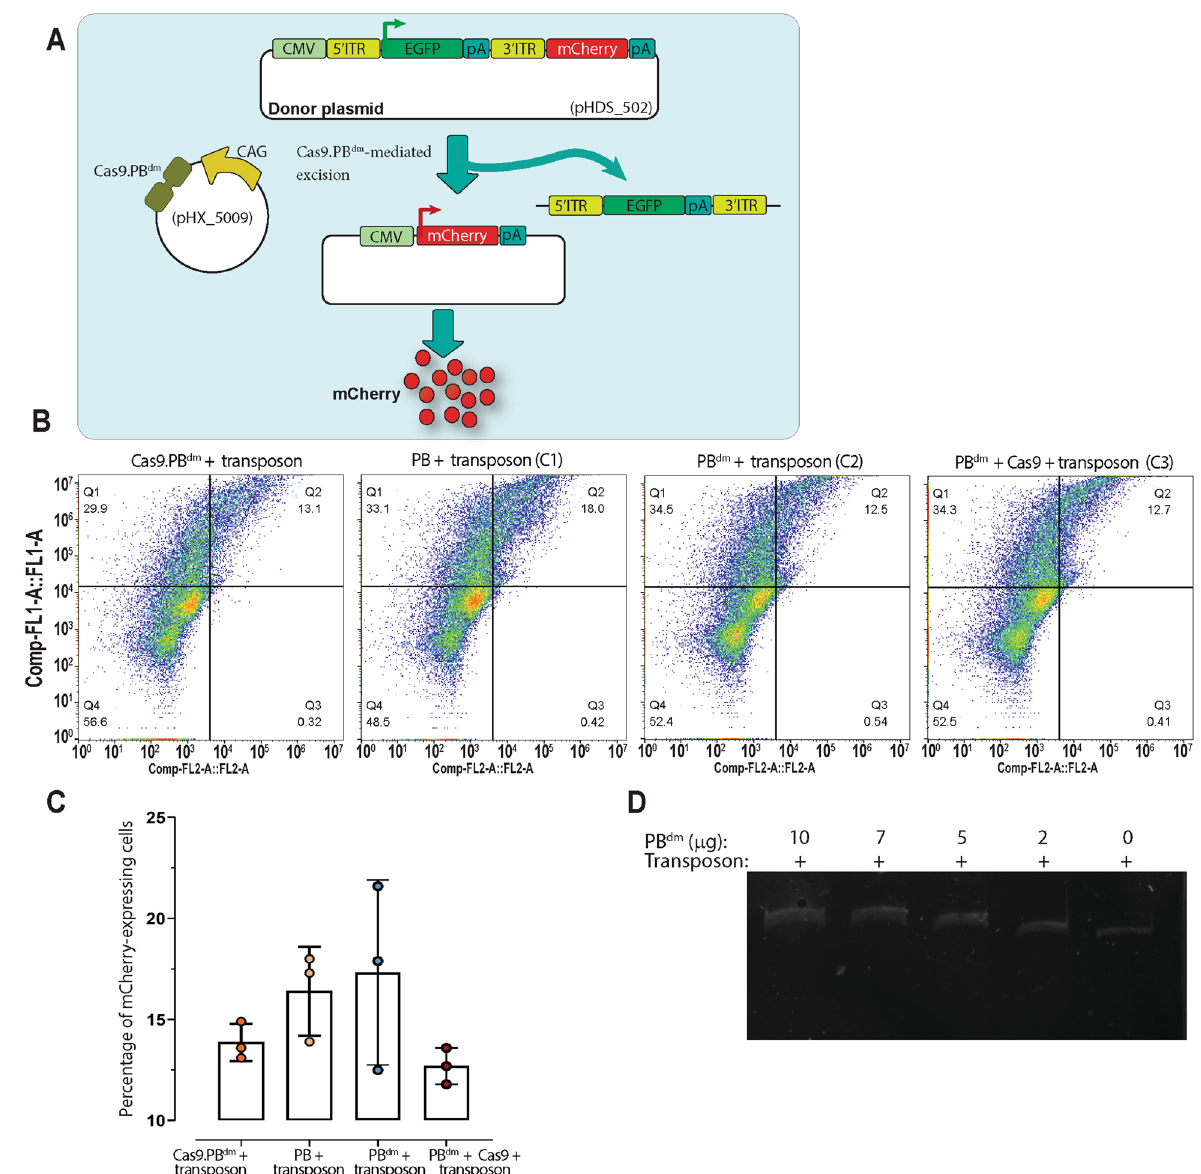
Figure 4. The excisionase activity of PB dm . ( A ) A donor plasmid with fragments CMV promoter, 5 ′ ITR, EGFP, poly-A signal (pA), 3 ′ ITR, mCherry, pA was used to evaluate the excisionase activity of PB dm moiety of the Cas9.PB dm molecule. To be able to compare the excisionase activity between PB dm and the wild-type PB, we did not use any sgRNA for targeting. The excision of an EGFP transposable element could result in the activation of expression of mCherry, and a shift from green to red fluorescence. ( B ) Representative flow cytometry analysis images for the main and 3 control groups (C1, C2, C3). Q1: EGFP/mCherry +/− ; Q2: EGFP/mCherry +/+ ; Q3: EGFP/mCherry −/+ ; Q4: EGFP/mCherry −/− . ( C ) The percentage of mCherry-expressing cells acquired by flow cytometry analysis was determined for the main experimental group and 3 control groups. ( D ) EMSA to examine the binding of PB dm to DNA transposon. The purified PB dm enzyme was incubated in increasing concentrations (from 0 to 10 μg for PB dm ) to 50 ng of a 1200-bp transposon. Then, the retardation in the migration of the PB dm enzyme was